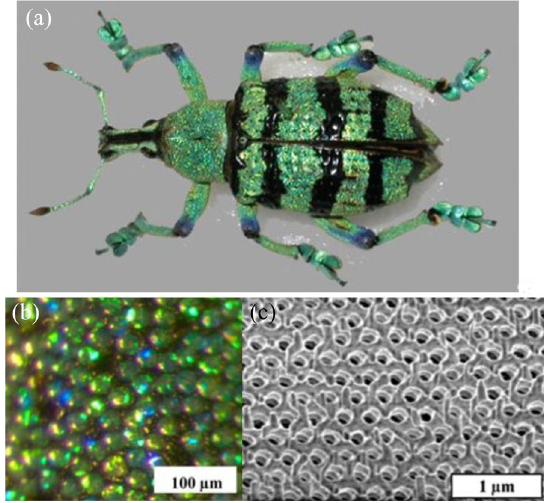
Figure 5 a Image of weevil E. chevrolati ; b SEM image of exoskeleton color scales of weevil E. chevrolati ; c SEM image of exoskeleton photon crystal structure of weevil E. chevrolati [49]